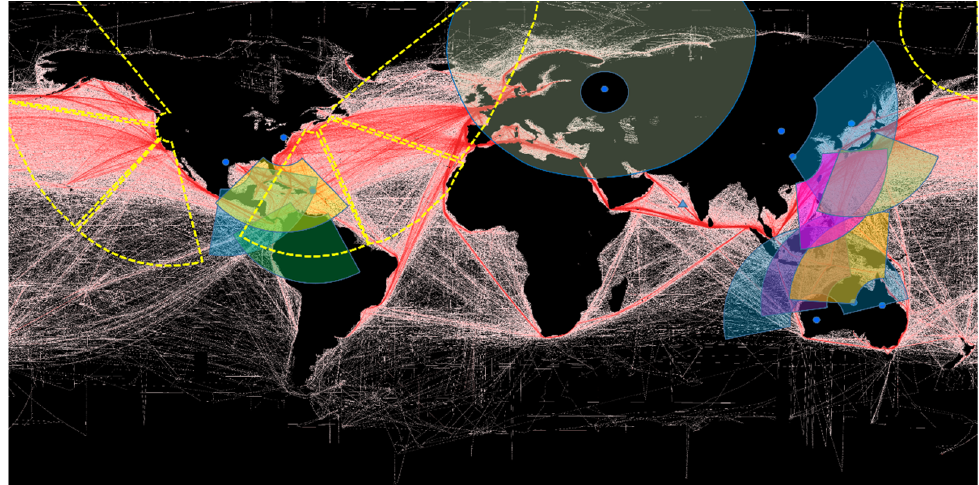
Figure 27. Nominal coverage of some major HF radars presently in operation (shaded in various pastel colors to enable them to be identified), together with that of the former (and possibly future) ECRS and WCRS radars (shown by dashed yellow lines).